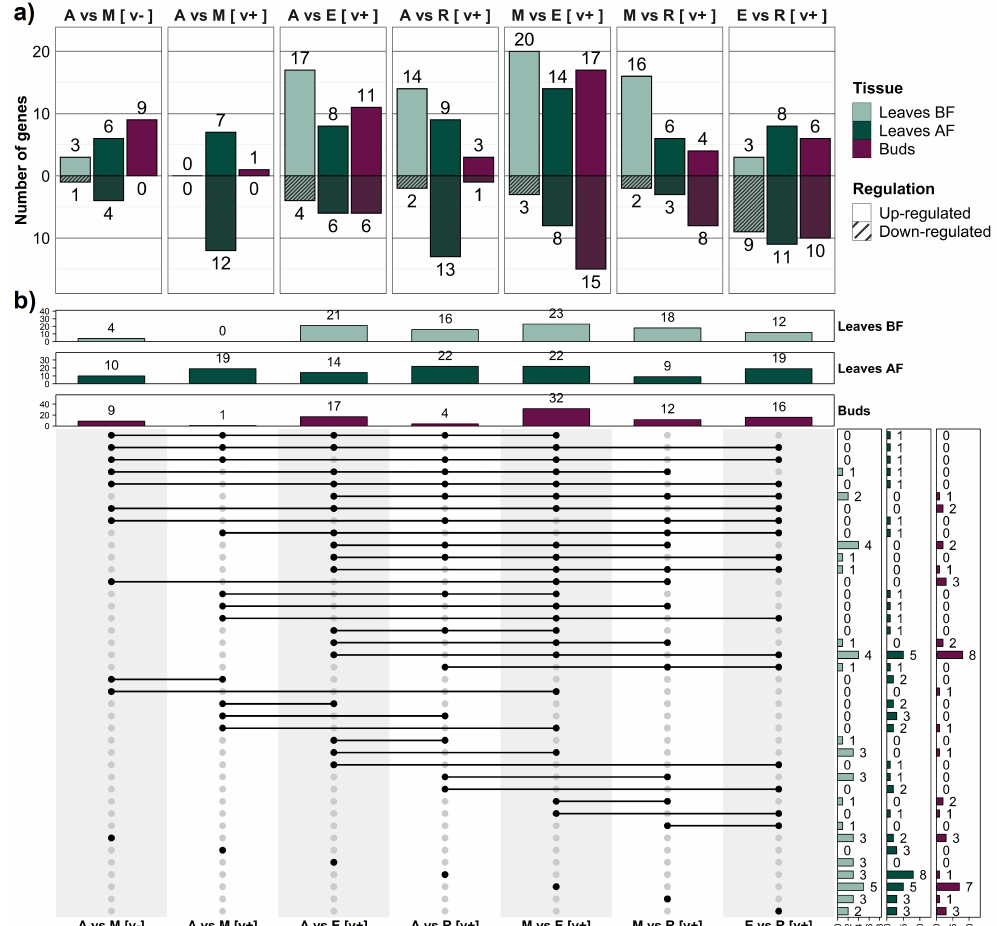
Figure 4. The number of flowering time genes differentially expressed between Cicer species/accessions. ( a ) The barplot shows the number of genes in different comparisons (top panel), where ‘A’— C. arietinum , ‘M’—ICCV 96029 mutant, ‘R’ – C. reticulatum , ‘E’— C. echinospermum ), ‘vern+’—after vernalization, ‘vern-’—without vernalization. Each comparison was analyzed in three tissue types: leaves BF, leaves AF, and buds. ( b ) The UpSet plot shows the number of genes differentially expressed in several comparisons simultaneously. Each column in the panel matrix corresponds to the comparison between the specified species/accessions; the rows represent all possible intersections of these comparisons (unique and overlapping DEGs). The panel matrix consists of filled and empty circles. Connected filled circles in a row indicate comparisons that are included in the intersection, while empty circles indicate that these comparisons are excluded from the intersection. If a circle is not connected with other circles, this comparison does not intersect with others. Three barplots in the top panel show the total number of genes differentially expressed between species/accessions in three tissue types. The three barplots at the right-hand side summarize the number of DEGs for each type of